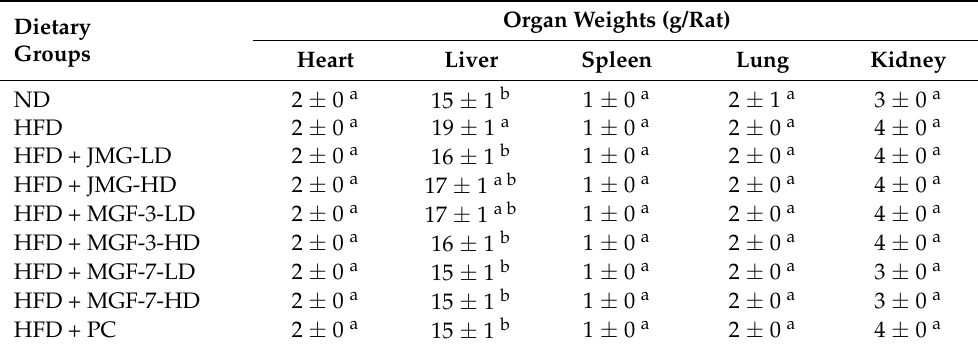
Table 3. Effects of Mei-Gin formulas on the weights of organs in high-fat diet-induced obese rats.